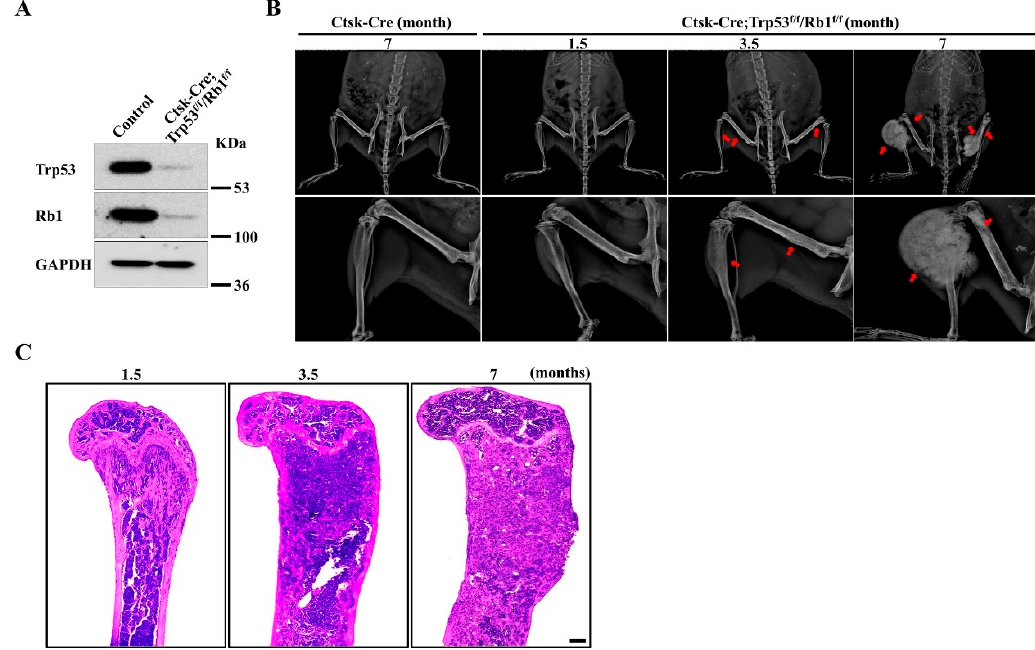
Figure 1. Loss of Trp53 and Rb1 in Ctsk-expressing cells causes osteosarcoma formation. ( A ) West- ern blot analysis of Trp53 and Rb1 expressions in Ctsk-expressing cells and normal cortical bone cells (control) as indicated. ( B ) Representative X-ray images of Ctsk-Cre;Trp53 f/f /Rb1 f/f mice and con- trols as indicated timepoint. The red arrows indicate the tumor in the bone. N = 5 mice per group. ( C ) Representative H&E staining images of femurs from the Ctsk-Cre;Trp53 f/f /Rb1 f/f mice as indi- cated timepoints. Scale bar, 1 mm. N = 5 mice per group.